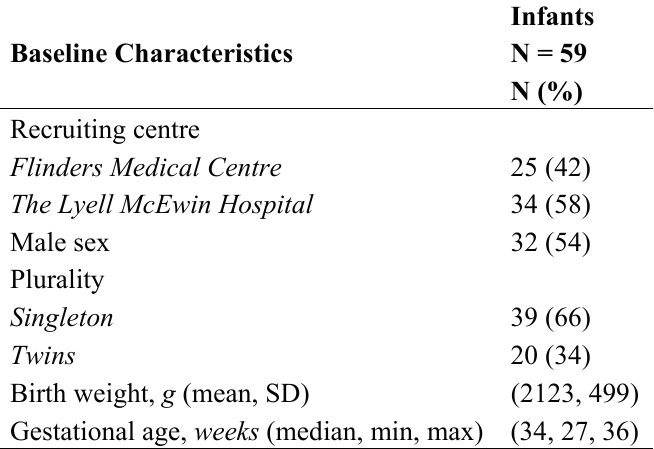
Table 1. Infant baseline